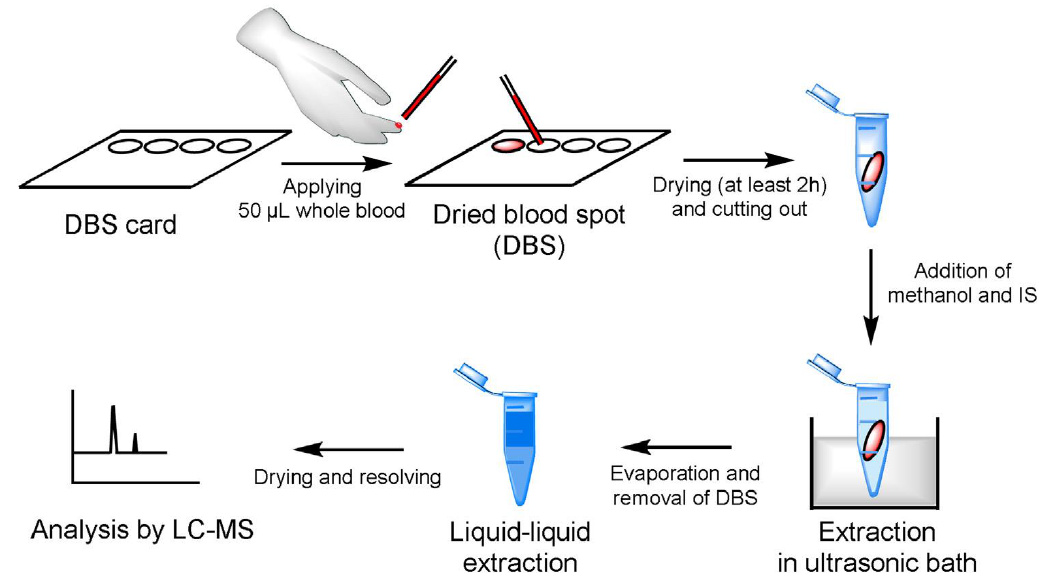
Figure 11. Dried blood spot extraction and sample purification workflow [111].